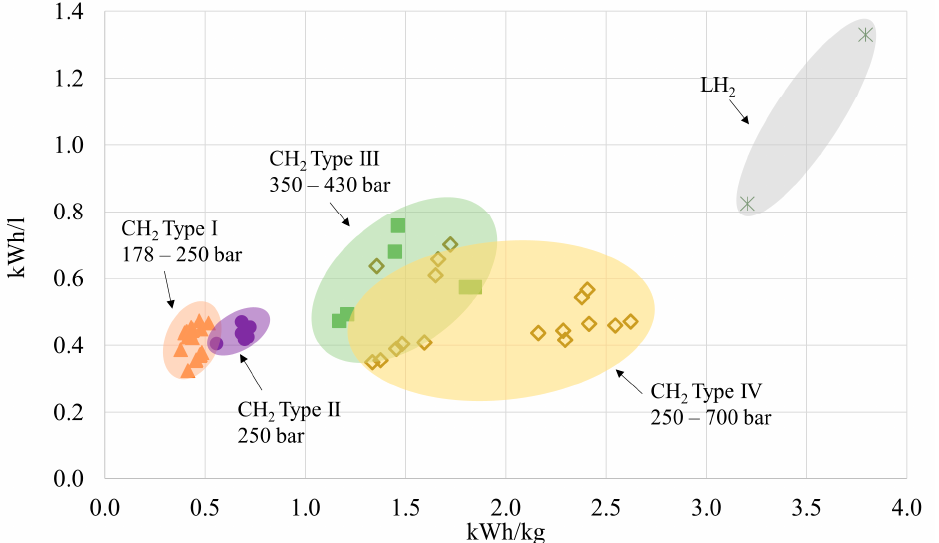
Figure 4. Energy density of different types of compressed hydrogen cylinders and liquid hydrogen tanks. Reproduced from a previous study by the authors [16].